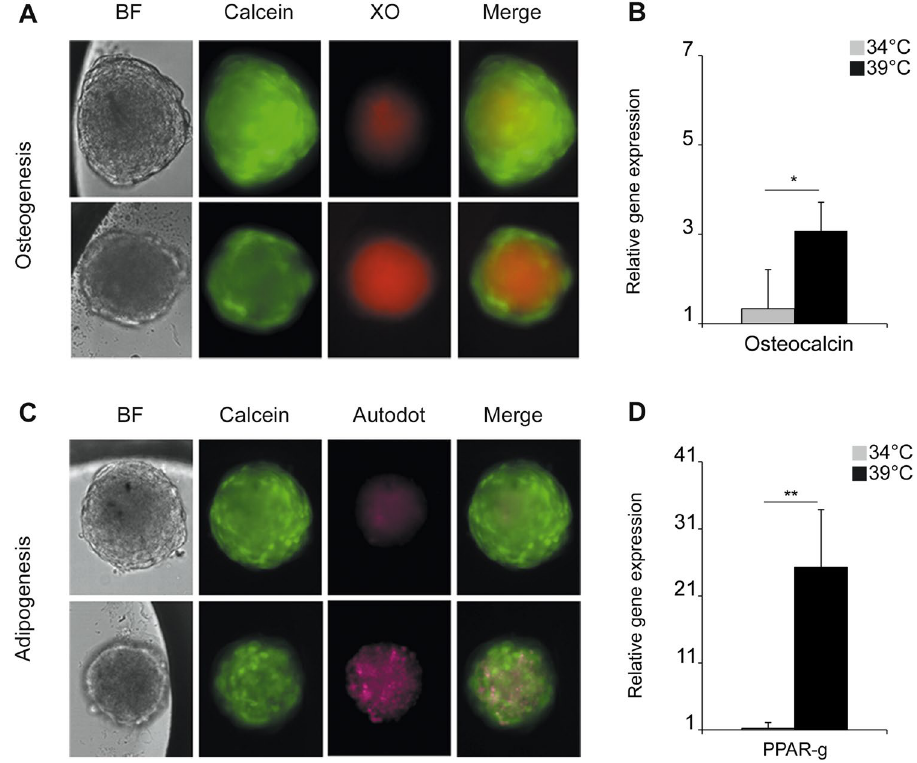
Figure 4. Differentiation of hFOB spheroids. ( A ) Spheroids were obtained using low attachment plates. 1000 cells were seeded per well and allowed to aggregate at the bottom of the plates for 48 h at 34 °C. Thereafter, plates were incubated for 3 days at 34 °C (upper panel) or at 39 °C (lower panel). Spheroids were stained with Calcein-AM (Calcein) and calcium deposition was visualized with Xylenol Orange (XO). For adipogenic differentiation ( C ) spheroids were incubated in adipogenic medium at 34 °C (upper panel) or 39 °C (lower panel) for 3 days. Cells were live-stained with Calcein and Autodot (pink). Images were taken using a DMi8 microscope (Leica) and acquisition analysis was performed with LAS X Software. (B, D) Quantitative PCR for the genes osteocalcin and PPARγ was performed to confirm osteogenic or adipogenic differentiation at day 4 post induction. Relative expression was normalized to hFOB cells grown in 2D at 34